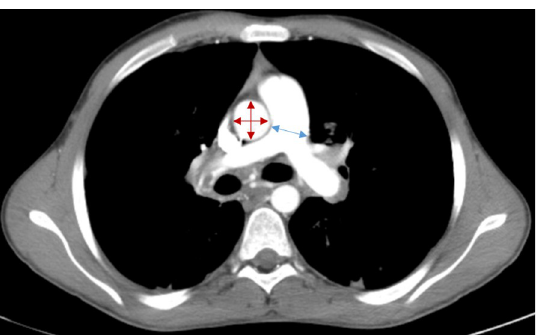
Fig 1. Pulmonary arterial enlargement in severe cystic fibrosis. A representative axial image of a CT scan at the level of the pulmonary artery (PA) bifurcation. The diameter of the PA is measured at the location indicated by the blue arrow. The diameter of the ascending aorta (A) is calculated using two perpendicular measurements indicated by the red arrows. PA enlargement (PA:A > 1) is present in this image.